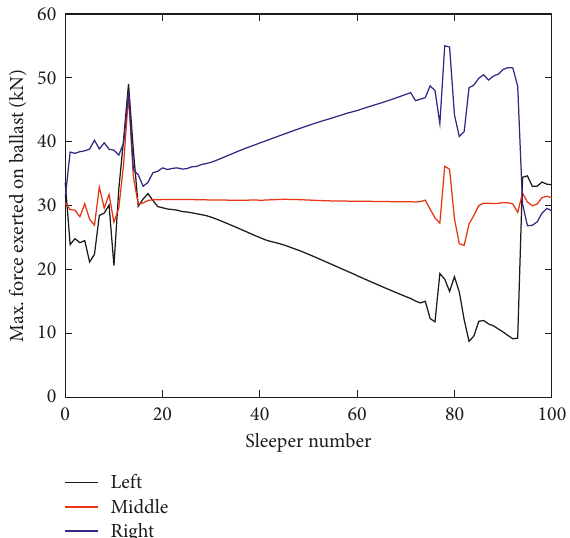
Figure 12: Maximum force exerted on the ballast.